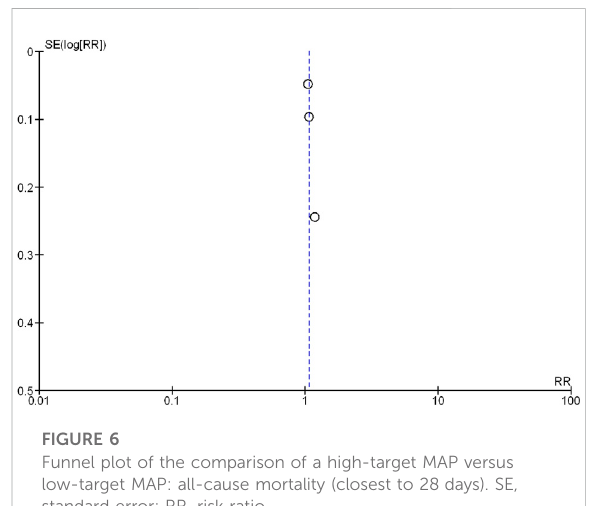
FIGURE 6 Funnel plot of the comparison of a high-target MAP versus low-target MAP: all-cause mortality (closest to 28 days). SE, standard error; RR, risk